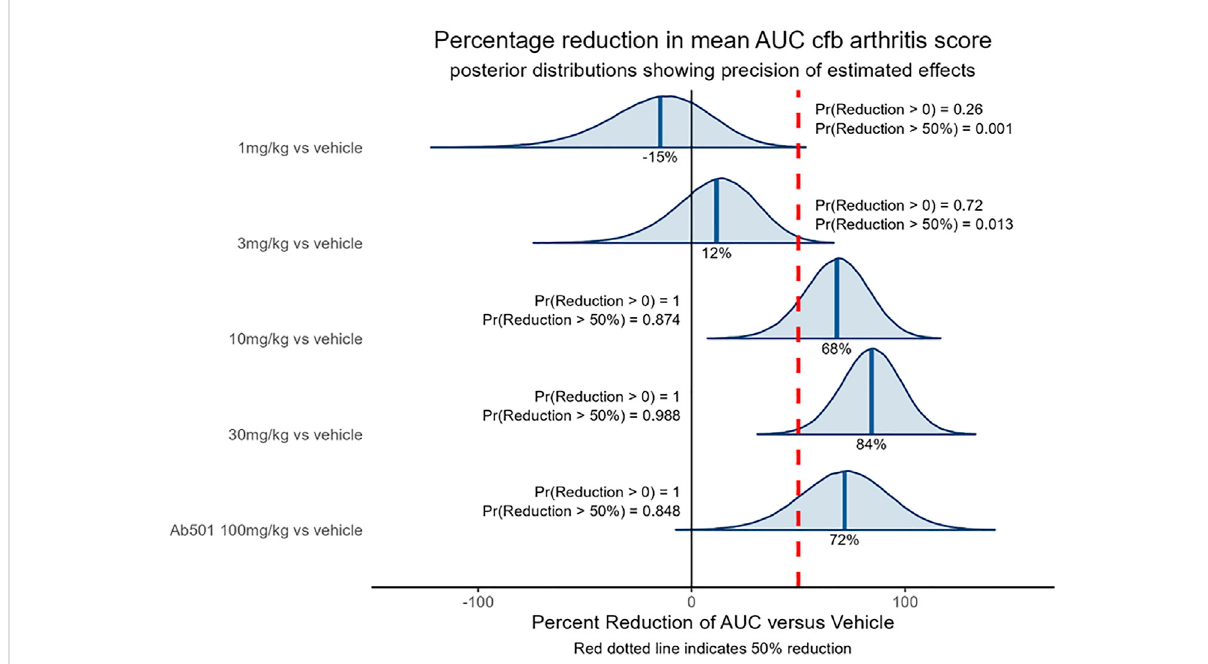
FIGURE 3 In vivo ef fi cacy of SAR441566 in the CIA Model: The dose dependent in vivo ef fi cacy of SAR441566 in the CIA model when dosed therapeutically. SAR441566 was dosed orally BID at 1, 3, 10 and 30 mg/kg. Mouse anti-TNF antibody (Ab501) was dosed at 100 mg/kg. Ef fi cacy assessed by the ability of SAR441566 to reduce the mean area under the curve (AUC) change from baseline (cfb) arthritis score compared to vehicle treatedmice. Percentinhibition ofeach groupisindicatedonthegraph. Dataanalyzed usingalinear modelsuitablefor therandomizeddesign. Reddottedlinerepresentsa50%reductionintheAUCofthediseasescore.Probability(Pr)statementsofscienti fi cinterestweremadeusingBayesian analysis. Graph shows combined data from 3 independent CIA studies. The data demonstrates that the in vivo ef fi cacy of SAR441566 at 10 and 30 mg/kgiscomparable toananti-TNFbiologic (Ab501).Vehicletreatedgroupn=50,SAR4415661 mg/kgn=17,3 mg/kgn=26,10 mg/kgn=31, 30 mg/kg n = 34 and Ab501 treated group n =